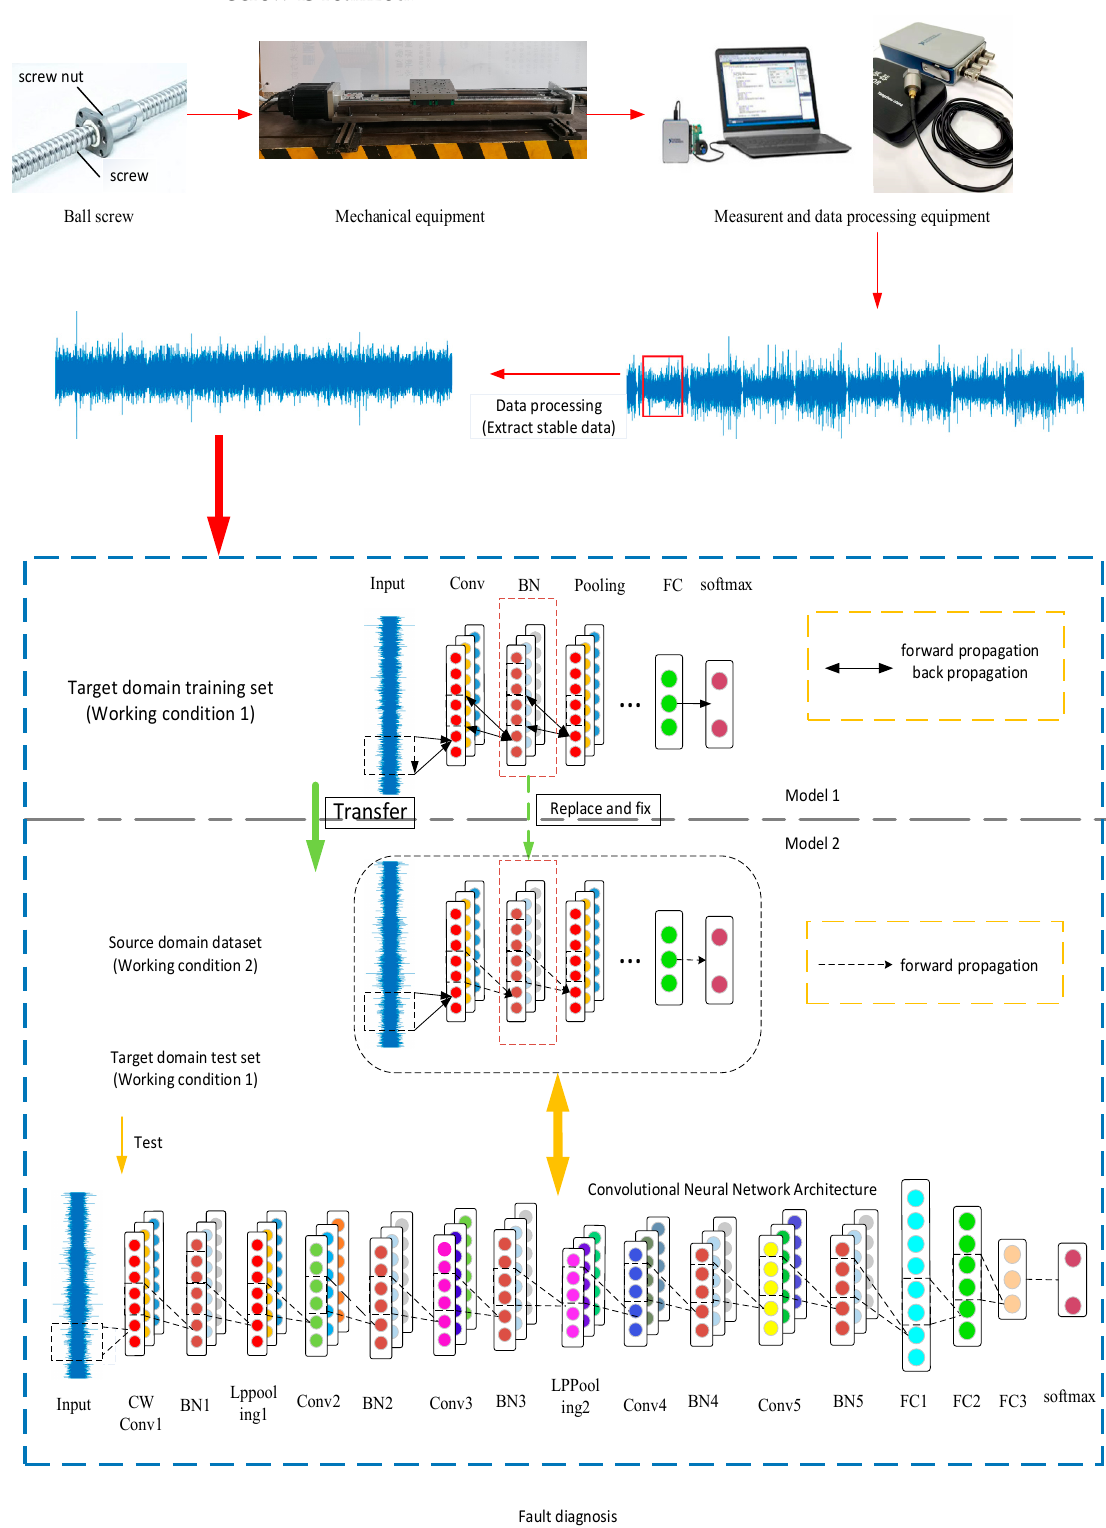
Figure 2. Transfer of fault diagnosis knowledge between different working conditions.